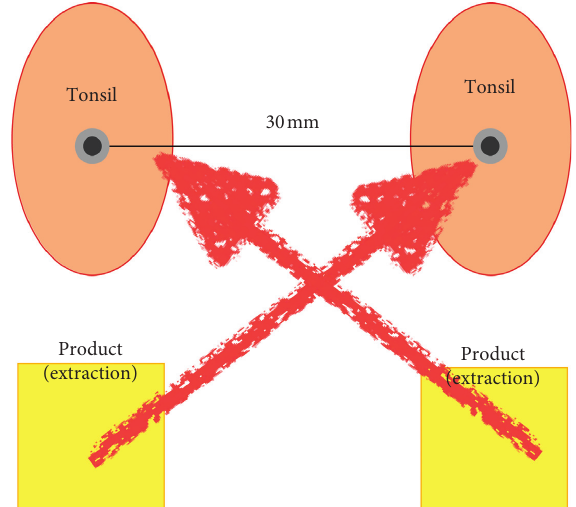
Figure 5: Relative position definition of oral optical simulation.